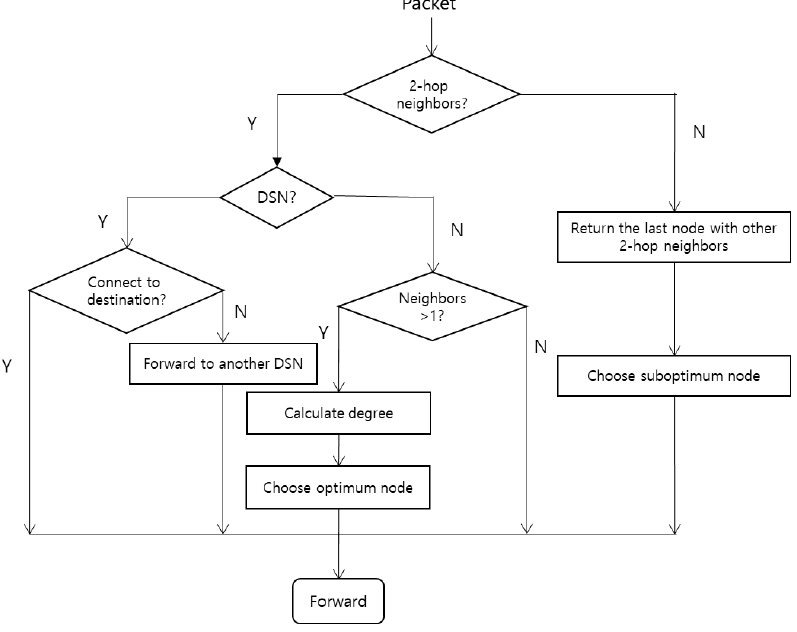
Figure 3. Evaluation framework of the intersection decision .